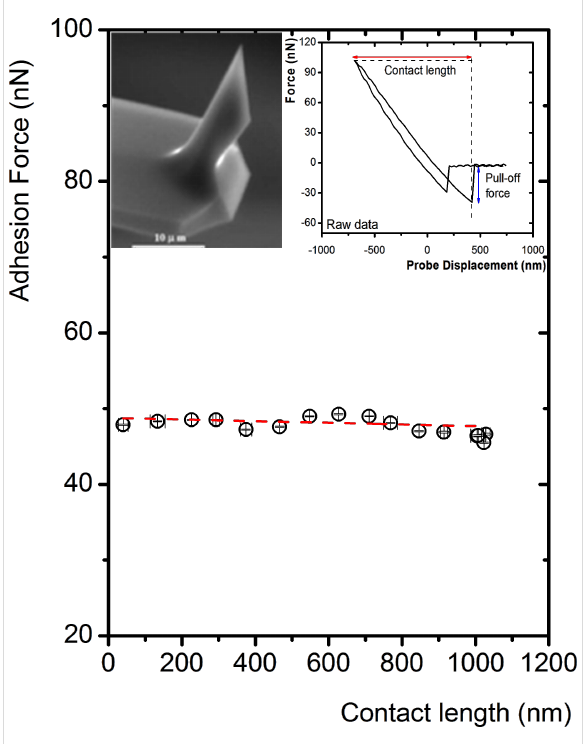
Figure 6: Pull-off force vs contact length; the red dash straight line is a guide to the eye. Right inset: A typical force-displacement curve on mica measured with a Si 3 N 4 tip in vacuum. Left Inset: Typical image of an AFM Si 3 N 4 tip obtained with a JSM5600-LVmicroscope .